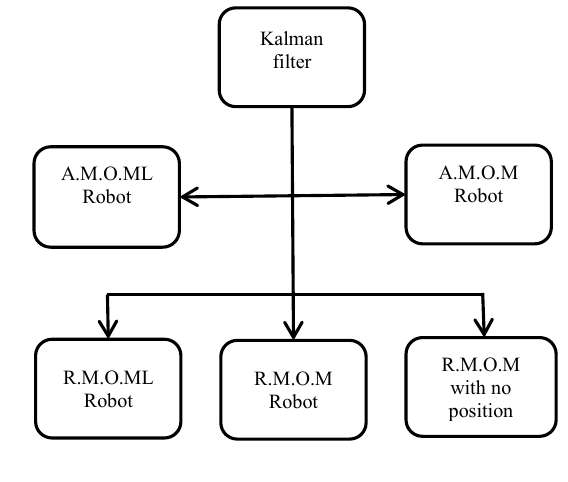
Fig. 3. Phases of Kalman